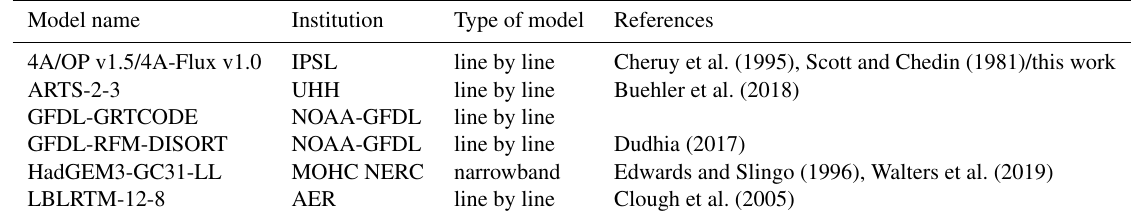
Table 2. List of the six benchmark models that have contributed to RFMIP-IRF and that are compared in this study. Model